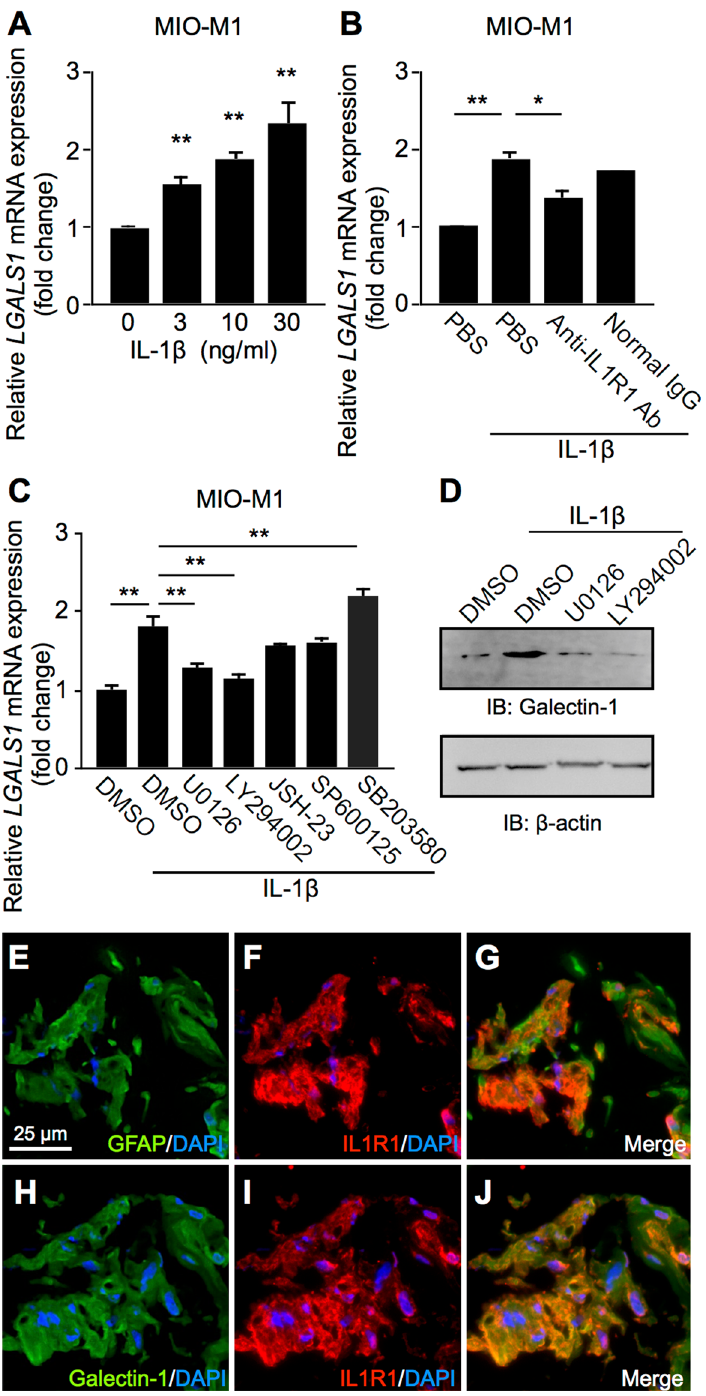
Figure 3. Galectin-1/ LGALS1 expression in Müller glial cells via IL-1 β -IL1R1 signaling. ( A ) MIO-M1 was treated with IL-1 β (3–30 ng/ml) for 24 hours, and LGALS1 expression was analyzed. ( B ) MIO-M1 was pretreated with a neutralizing antibody against IL1R1 (10 μ g/ml) and control normal IgG (10 μ g/ml) for 30 minutes followed by treatment with IL-1 β (10 ng/ml) for 24 hours, and LGALS1 gene expression levels were analyzed. ( C–D ) MIO-M1 was pretreated with each inhibitor at 10 μ M for 30 minutes before cultured with IL-1 β (10 ng/ml) for 24 hours, and LGALS1 gene and protein expression levels were analyzed. * p < 0.05, ** p < 0.01 (n = 8 per group). Full-length blots are presented in Supplementary Fig. S3. ( E–G ) Double labeling of GFAP ( green ), IL1R1 ( red ) and DAPI ( blue ) in PDR fibrovascular tissues. ( H–J ) Double labeling of galectin-1 ( green ), IL1R1 ( red ) and DAPI ( blue ) in PDR fibrovascular tissues. Scale bar = 25 μ